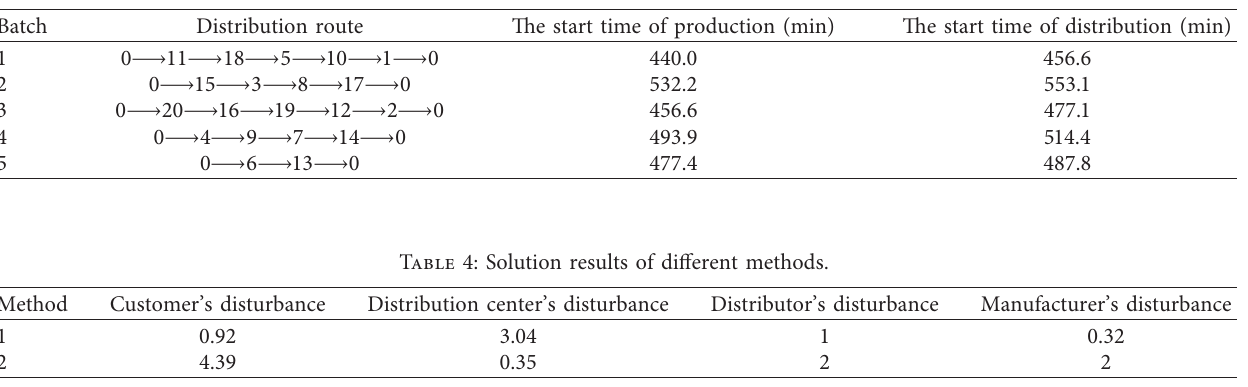
Table 3: Table of the initial production-distribution